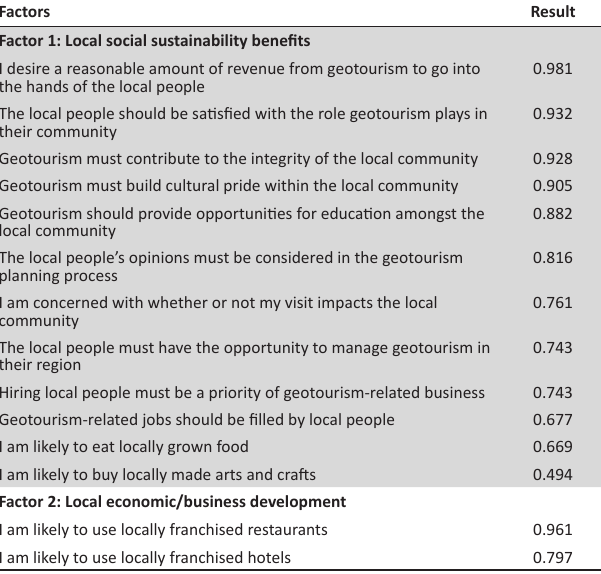
TABLE 6: Factor analysis for potential benefits of geotourism.